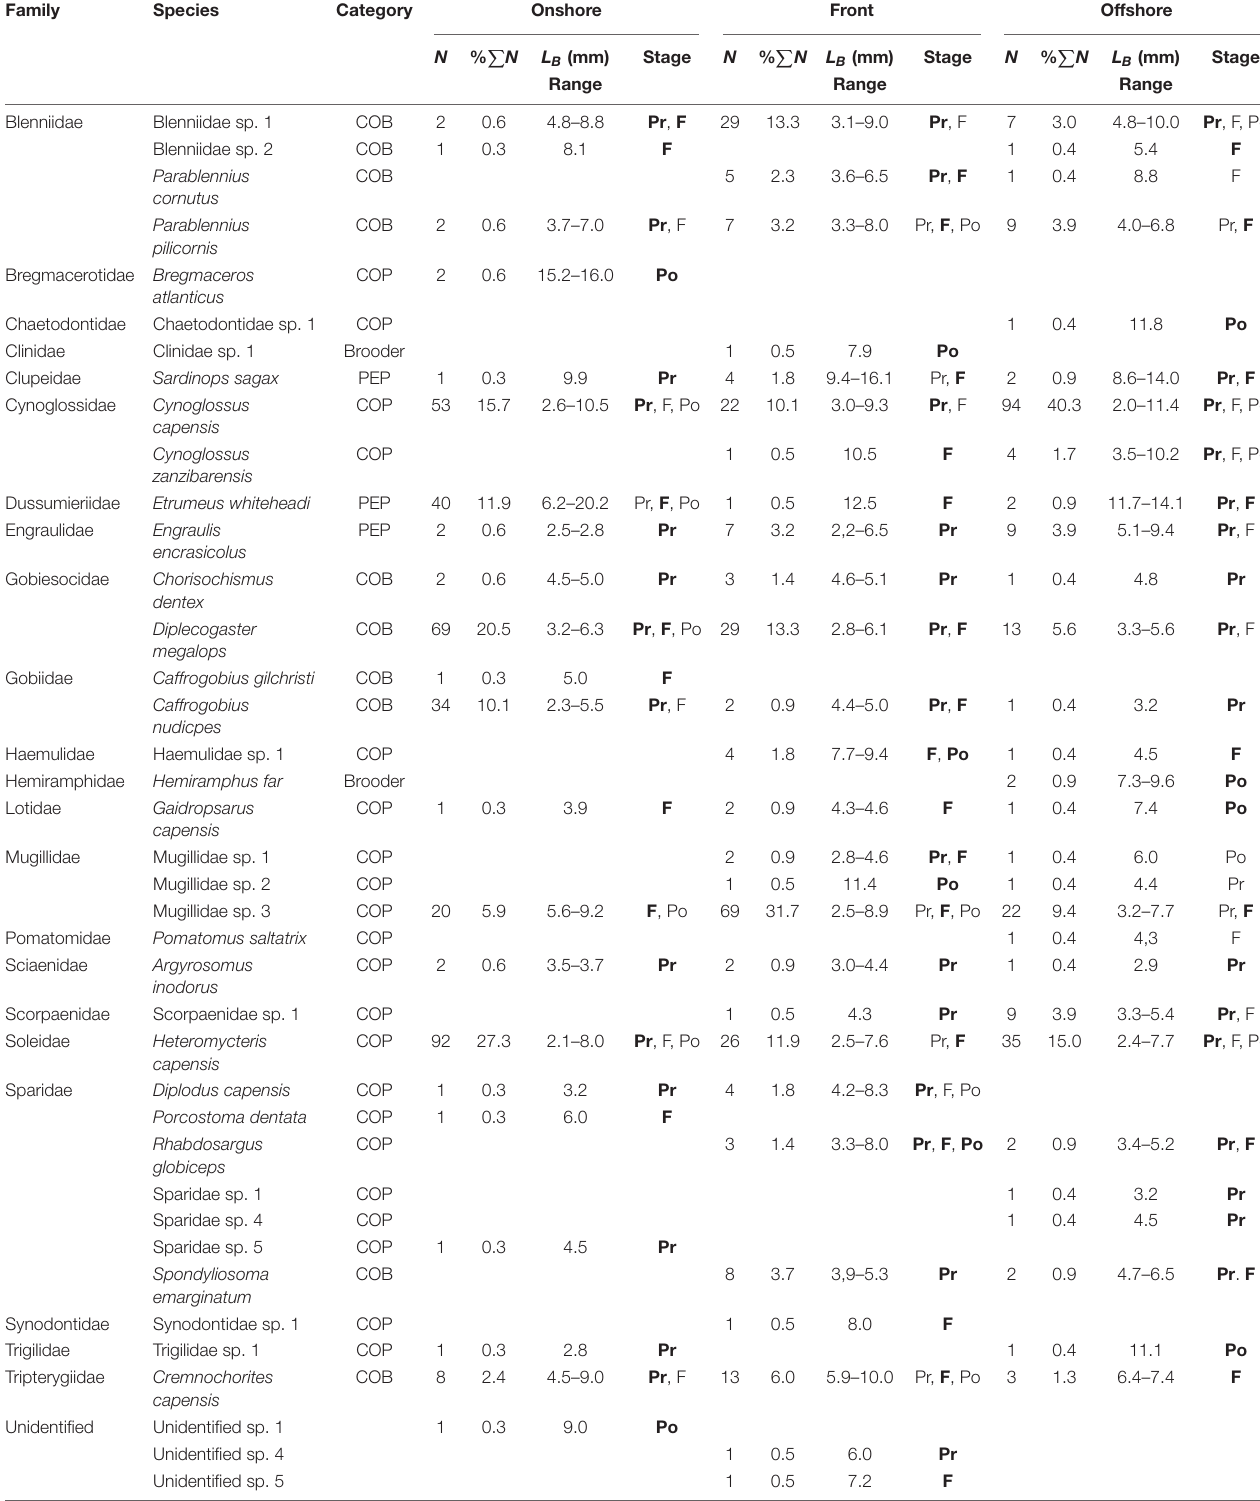
TABLE 3 | Species composition by number ( N ) and as a percentage of total catch (% P N ), mean body length ( L B ), and developmental stage (Pr, preflexion; F, flexion; Po, postflexion) of larval fishes caught by bongo net in the nearshore surface slicks in Sardinia Bay. Family Species Category